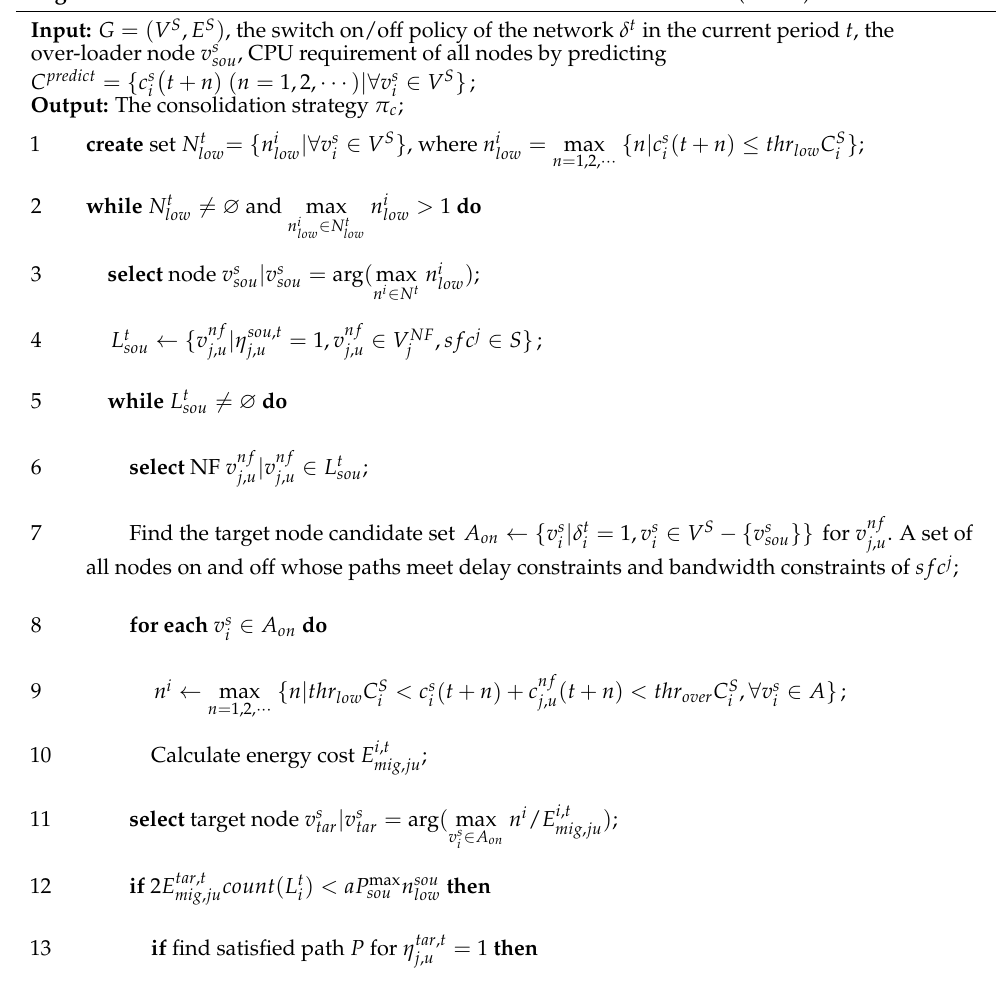
Algorithm 3 Resource Prediction Based Network Function Consolidation